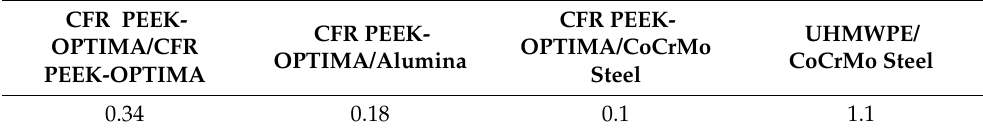
Table 4. Total Wear Factors (values times 10 − 6 mm 3 /Nm) for Carbon Fiber-Reinforced PEEK- OPTIMA against different Counterparts and UHMWPE against CoCrMo steel